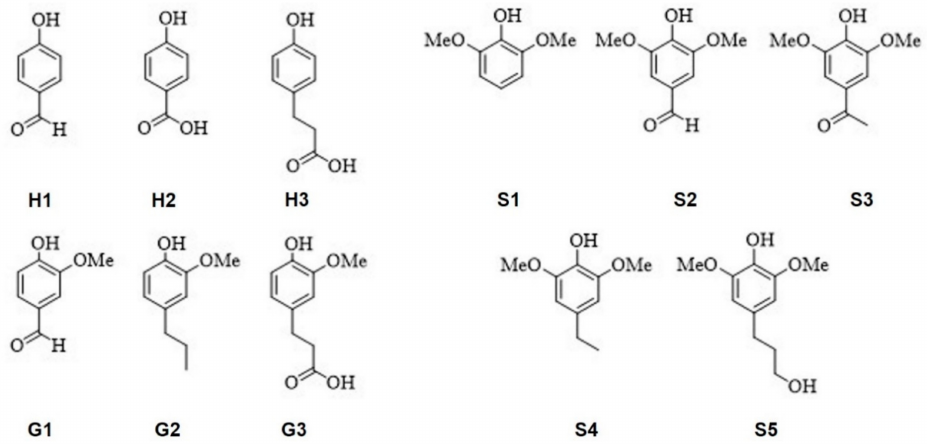
Figure 6. Summary of monomer products obtained from bagasse lignin’s